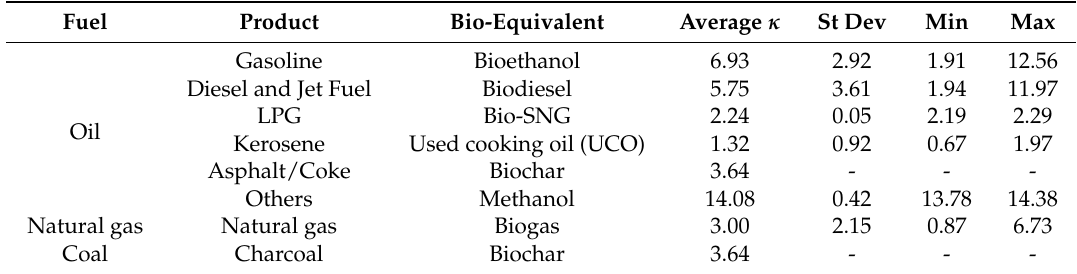
Table 2. Exergy cost of bioproducts from crop to